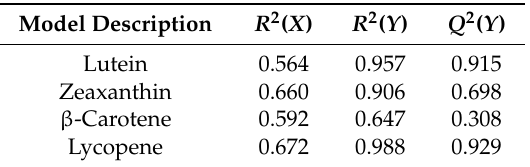
Figure 4. Graphical representation of the OPLS-models’ output, relating the observed and predicted Y -variables ( i.e. , carotenoid concentrations). Individual valid models were generated for: ( a ) lutein; ( b ) zeaxanthin; ( c ) β -carotene; and ( d ) lycopene. Table 2. OPLS models that were able to predict tomato fruit carotenoid concentrations based on metabolic fingerprints. Validation of these models was performed based on CV-ANOVA ( p -value < 0.05), permutation testing and three model characteristics (( R 2 ( X ), R 2 ( Y ), and Q 2 ( Y )). All of the presented models performed well for CV-ANOVA and permutation